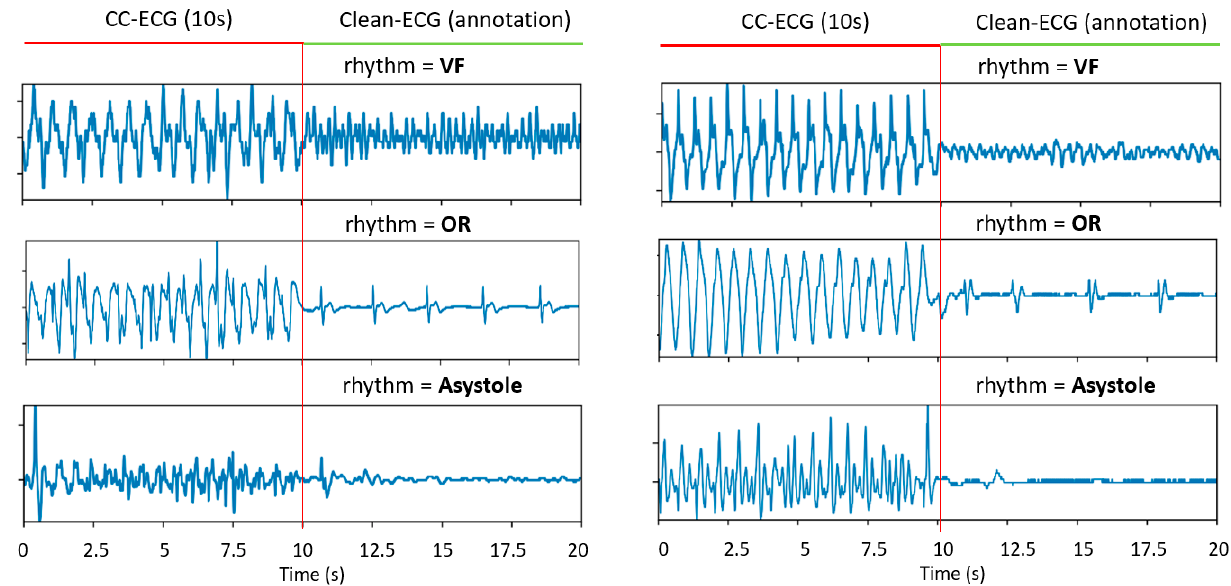
Figure 1. Rhythm annotation scheme during CPR: AED analysis periods (10 s of clean-ECG) were used for rhythm annotation. The rhythm during the preceding period with chest compressions (10 s of CC-ECG) was considered consistent.